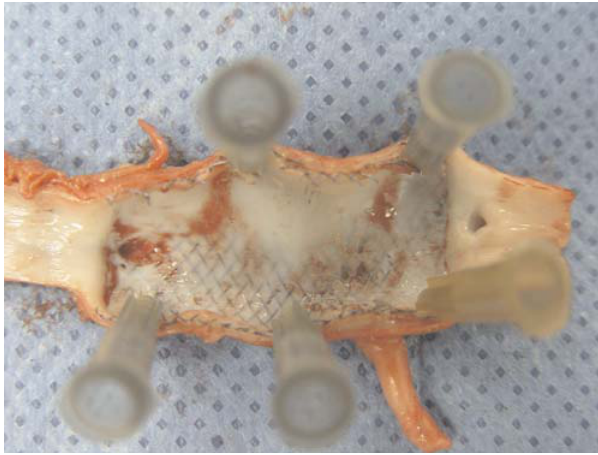
Figure 2 - Macroscopic view of stent in pig aorta in Group C